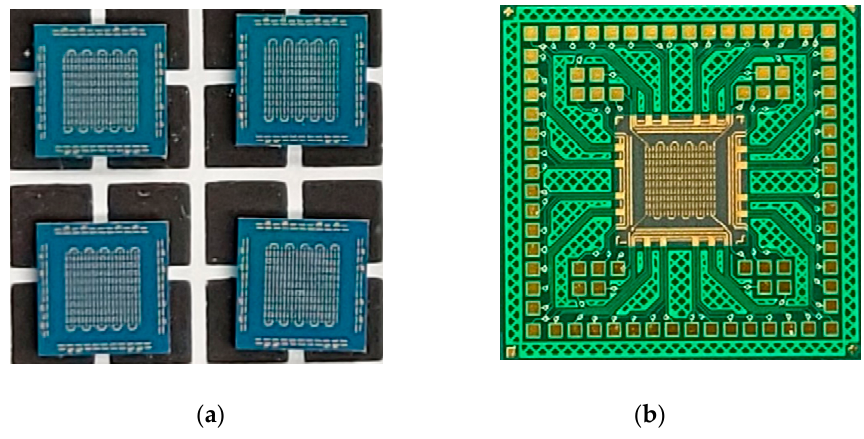
Figure 1. ( a ) Test chip and ( b ) test substrate in this study.